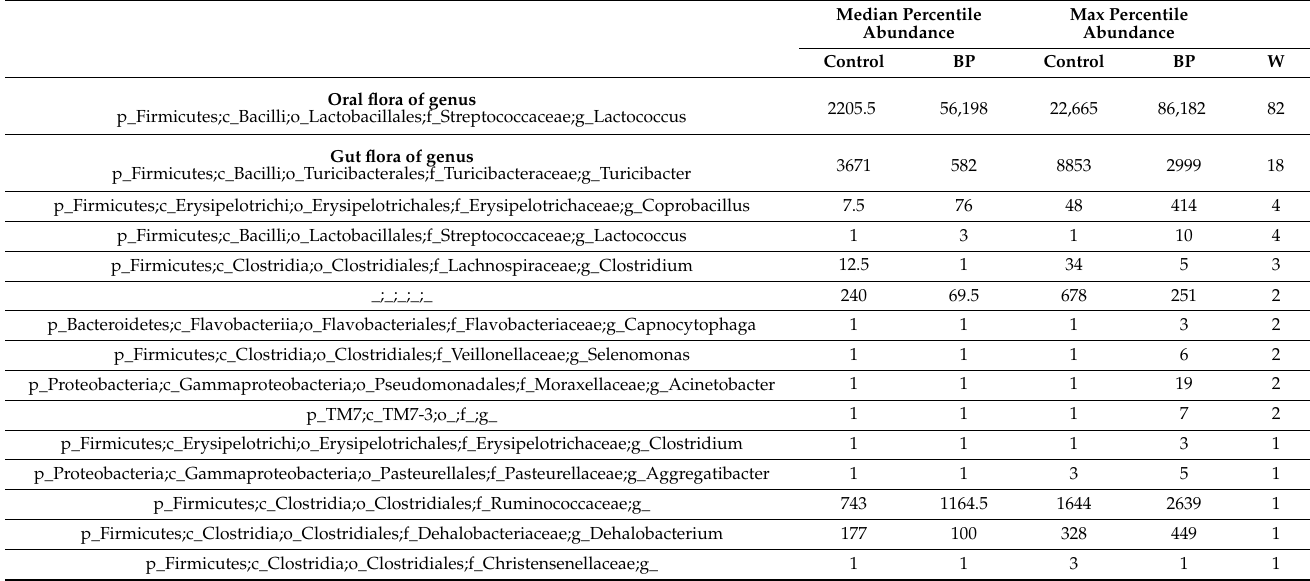
Figure 5. Oral and gut bacterial taxonomy. ( a ) The most abundant genus in the oral microbiome was Lactobacillus, followed by Lactococcus and Staphylococcus. ( b ) The most abundant genus in the gut microbiome was S24-7;g , followed by Lachnospiraceae and Bacteroides. Table 2. The ANCOM results and percentile abundances of features in each